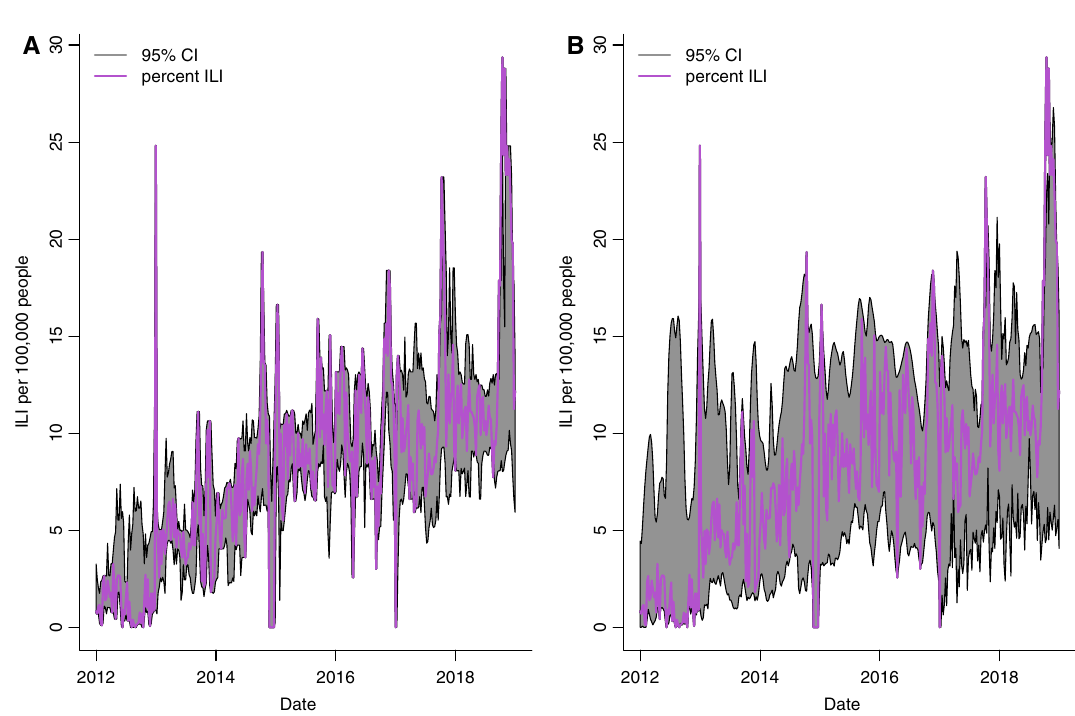
Figure 6. 95% Confidence Intervals (CI) for 1-week-ahead predictions of the rate of ILI per 100,000 inhabitants the Littoral region. Models were fit using 5 years of data; week 1 to 261. Forecasts for the next week, t + 1, were made at week, t. Estimates using (A) Random Forest Regression and (B) Support Vector Machine Regression (SVM) are